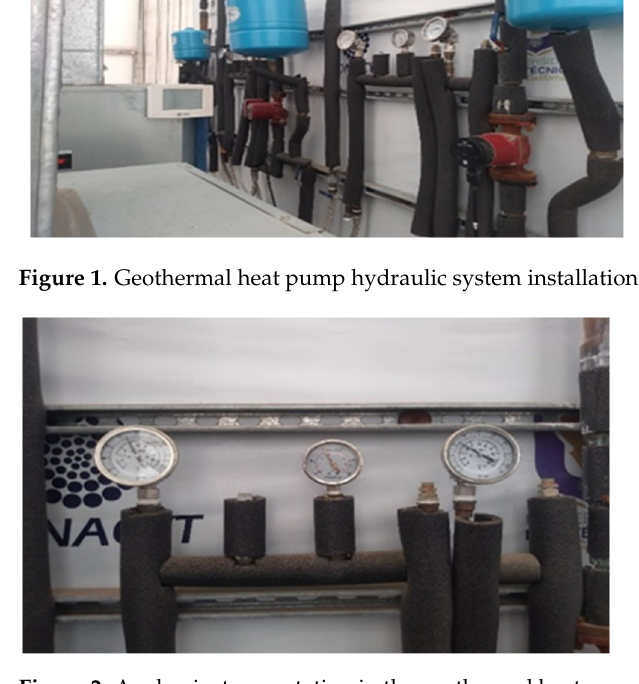
Figure 2. Analog instrumentation in the geothermal heat pump analysis was installed. Table 1. Instrumentations details of the sensor used to analyze the geothermal heat pump’s performance.